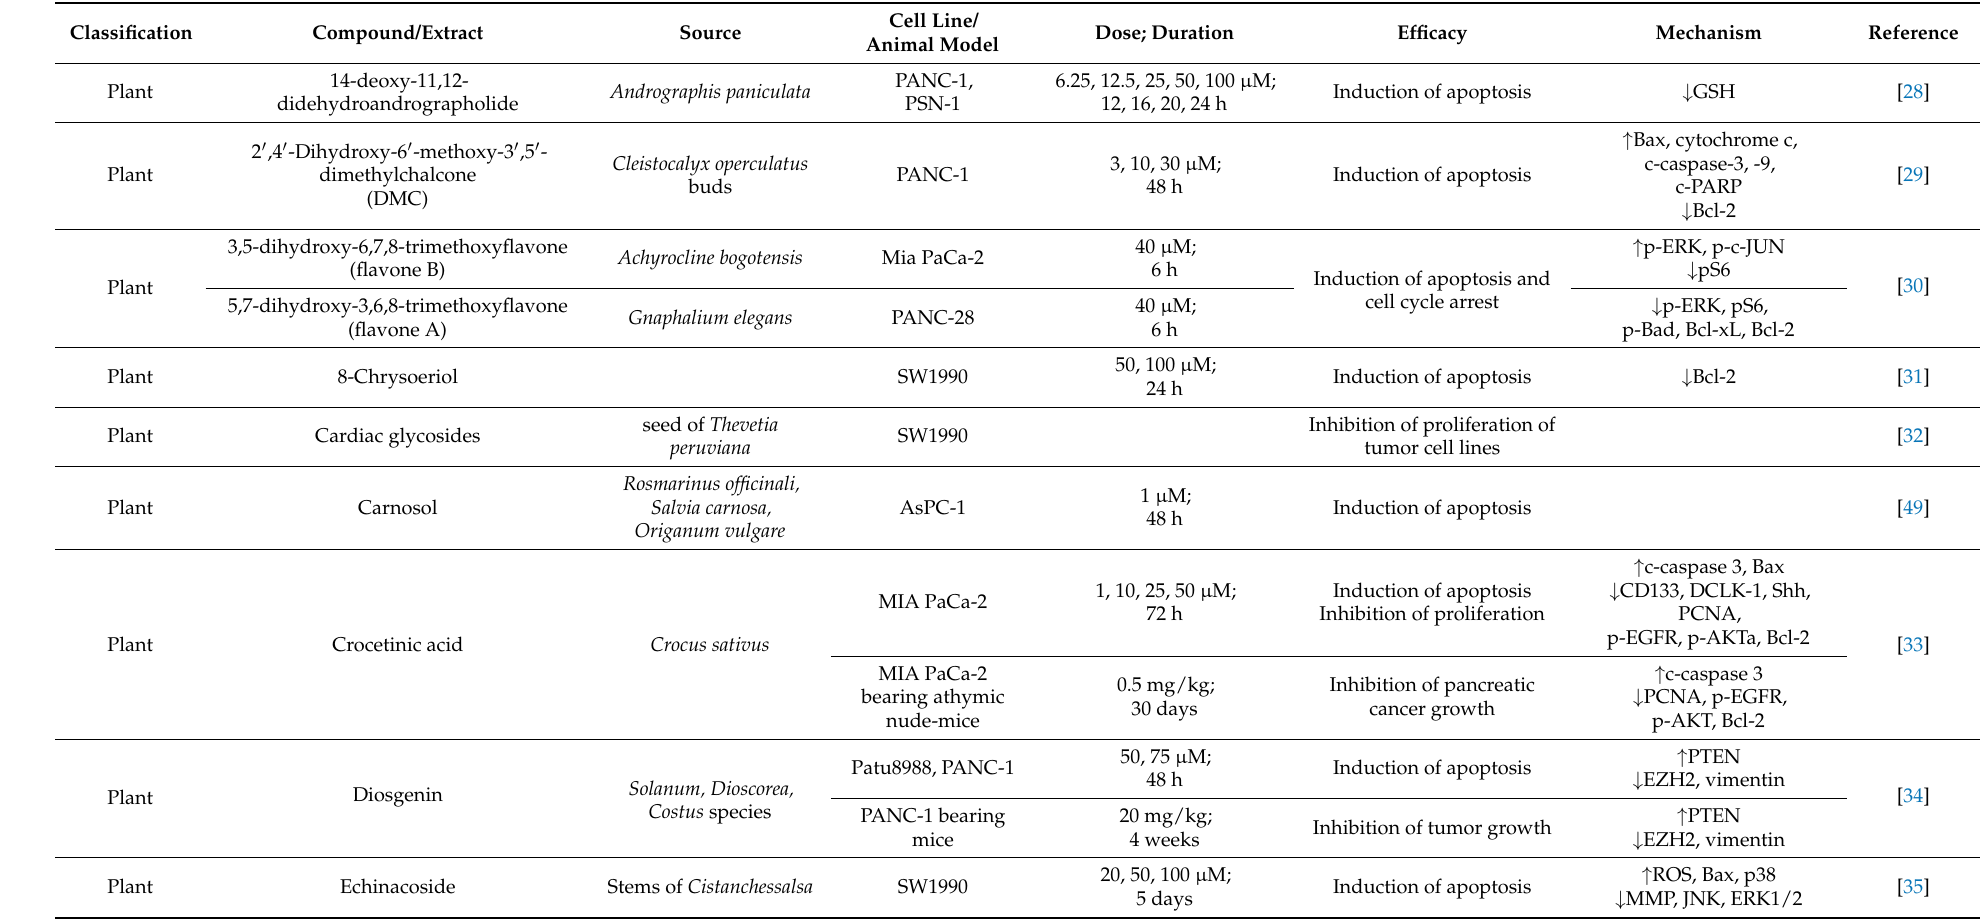
Table 3. Apoptosis inducing